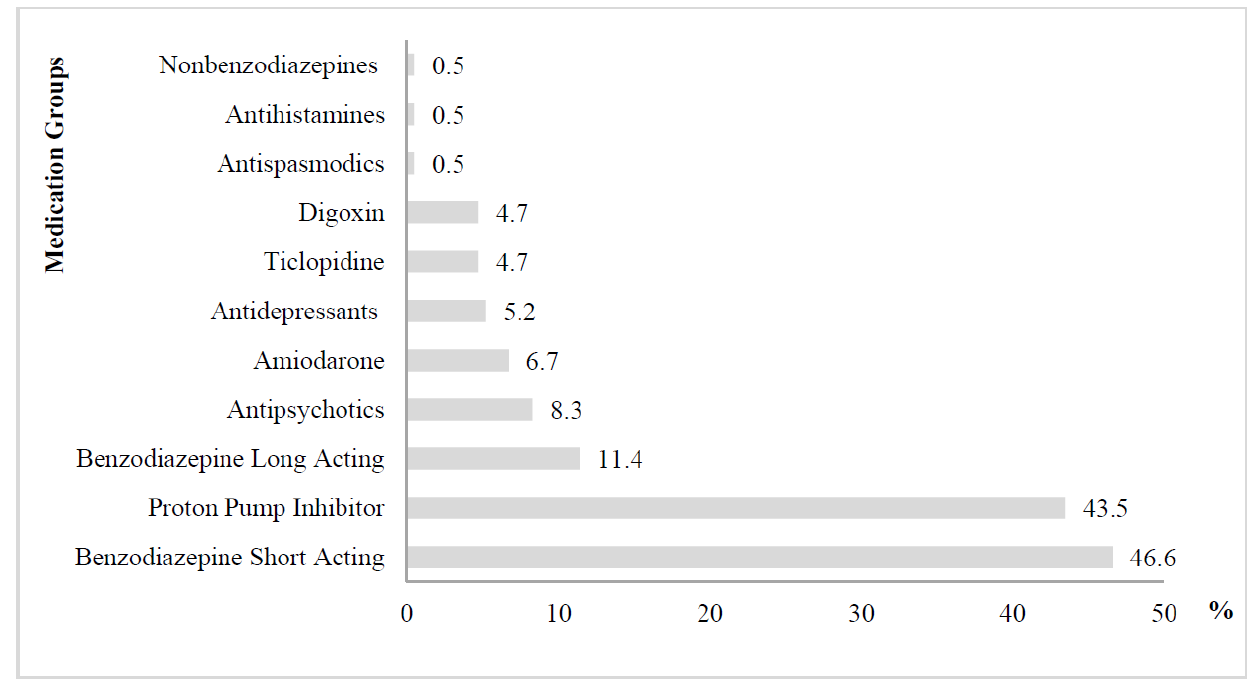
Figure 3. Therapeutic classes and drugs to be avoided for most older adults according to the Beers Criteria (independent of diagnoses or conditions).